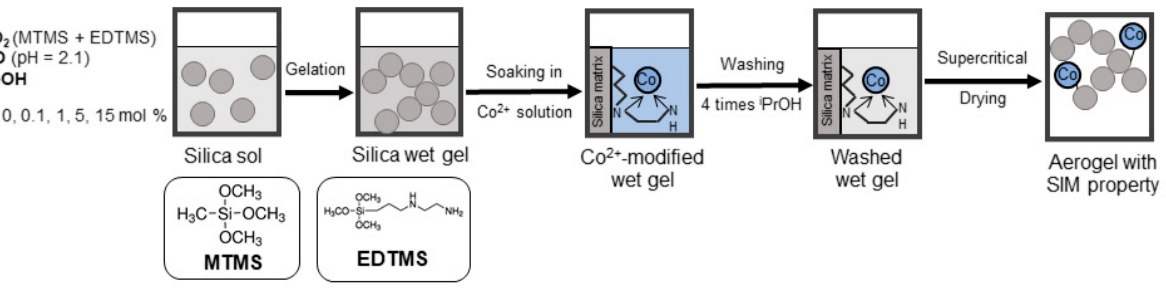
Figure 12. The preparation of silica-based cobalt-modified SIM materials.